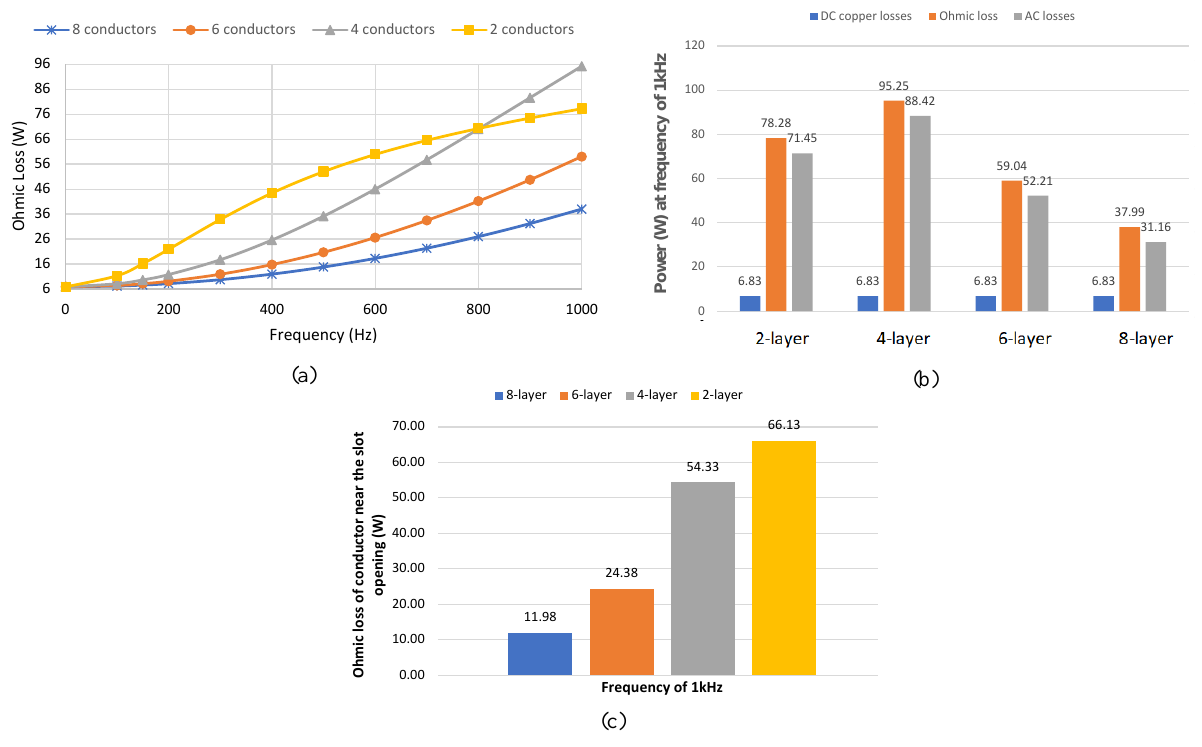
Figure 8. ( a ) Numerical results of ohmic losses for various conductor layers, ( b ) DC, AC, and total ohmic losses of layouts at 1 kHz, and ( c ) ohmic loss for the layer near the slot opening at 1 kHz for various setups.